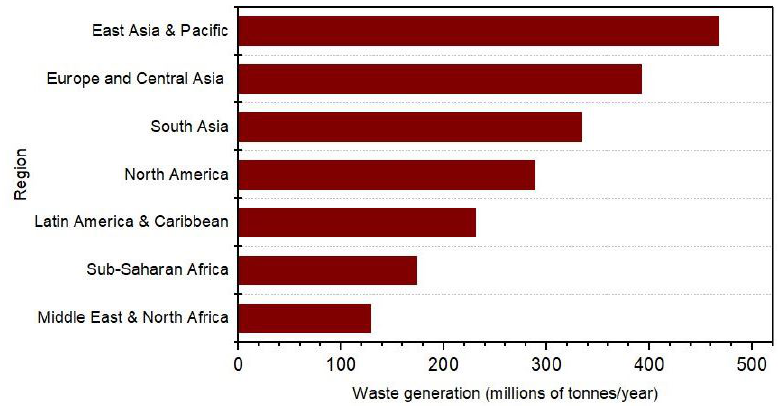
Figure 2. Projected waste production by region (millions of